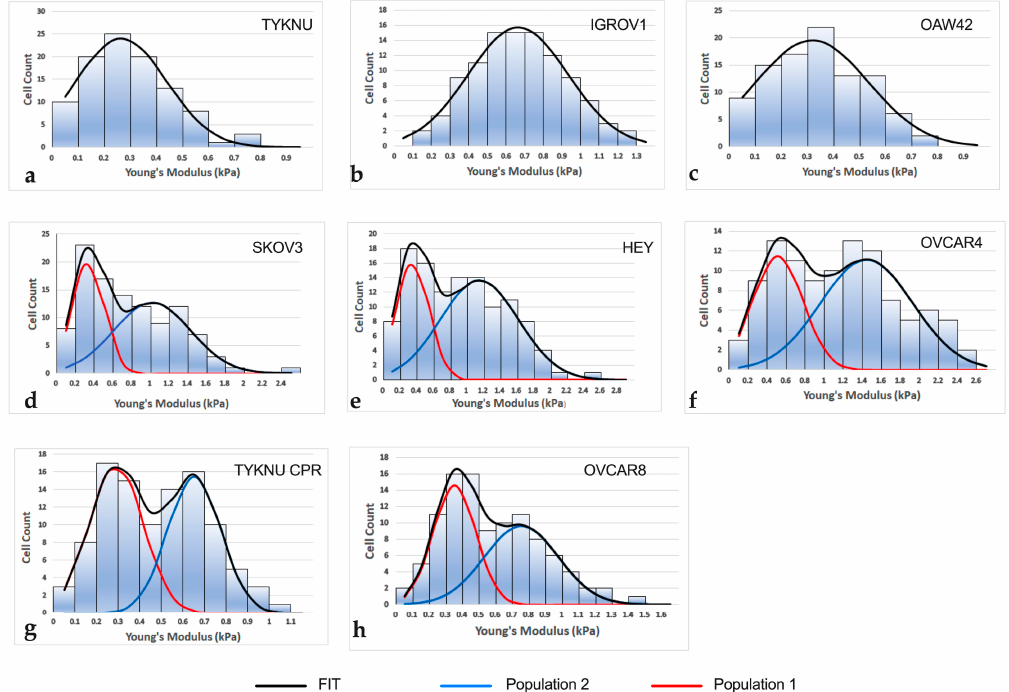
Figure 1. Distribution pattern of single-cell elastic moduli for the analyzed cell lines. Histograms of cell lines with Gaussian stiffness distribution ( a – c ). Histograms of cell lines with bimodal stiffness distribution ( d – h ). FIT: fitting by peak deconvolution method. Population 1: lowest ‐ stiffness population; Population 2: highest ‐ stiffness population.